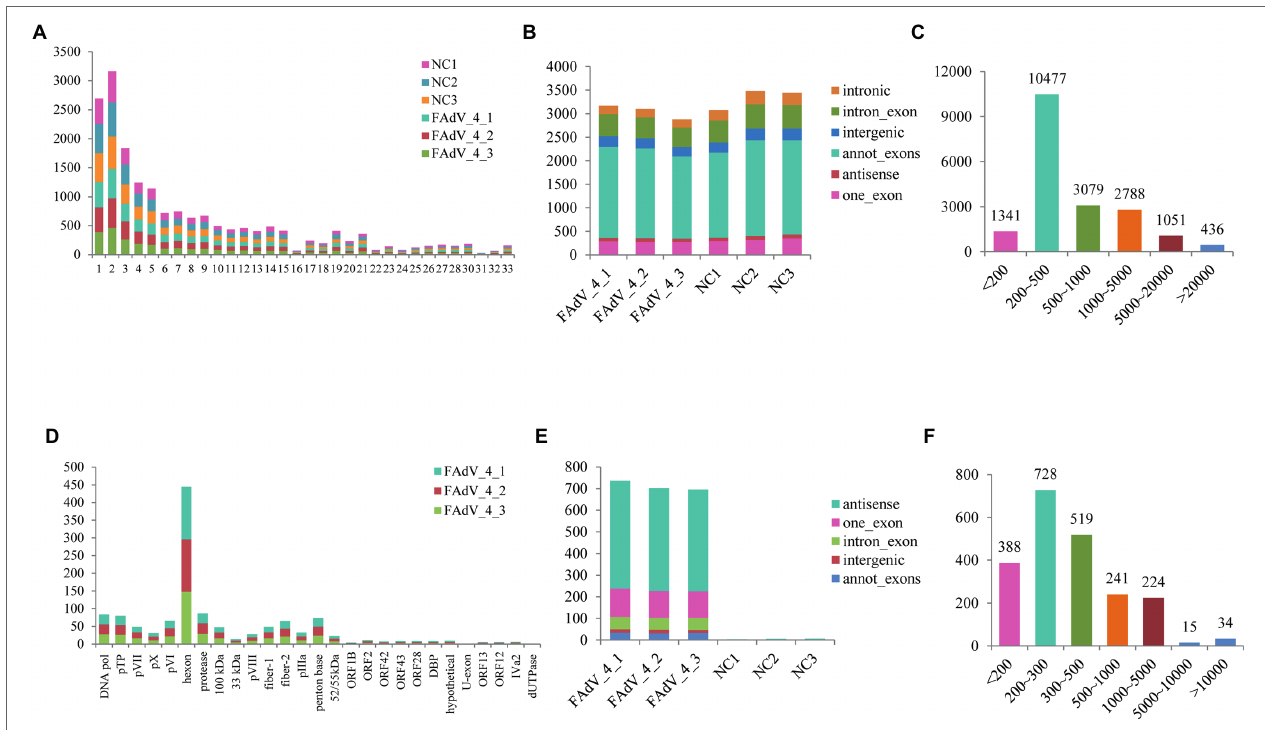
FIGURE 2 | Characterization of identified circRNAs. (A) Quantitative distribution of ggacircrna (circRNA encoded by chicken genome) on different chromosome. (B) The type of identified ggacircRNAs in the six samples. (C) The distribution of identified ggacircRNAs sequence length. (D) Quantitative distribution of FadVcircrna (circRNA encoded by FAdV-4 genome) on different coding sequences (CDSs). (E) The type of identified FAdVcircRNAs in the six samples. (F) The distribution of identified FAdVcircRNAs sequence